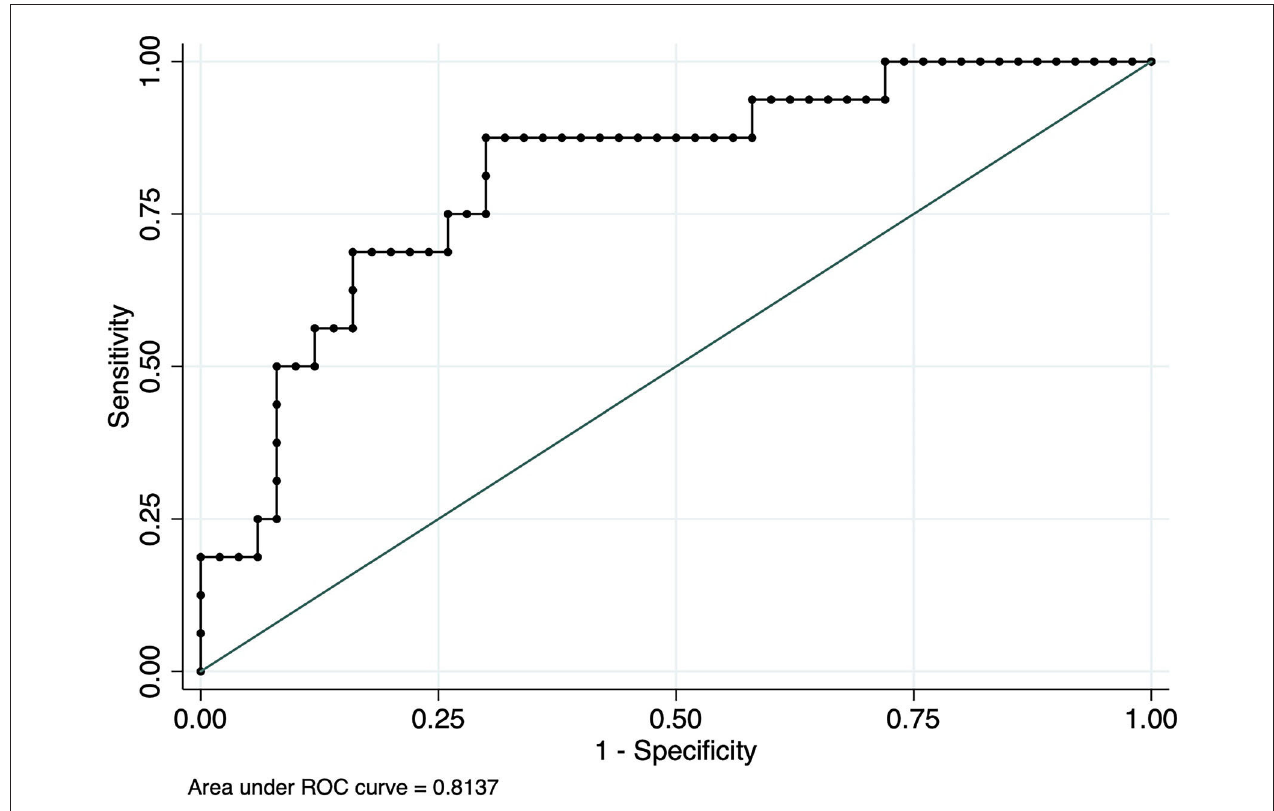
FIGURE 3 | Receiver operator characteristic (ROC) curve analysis using serum ADM to distinguish myocardial ischemia-related T wave in patients with lung